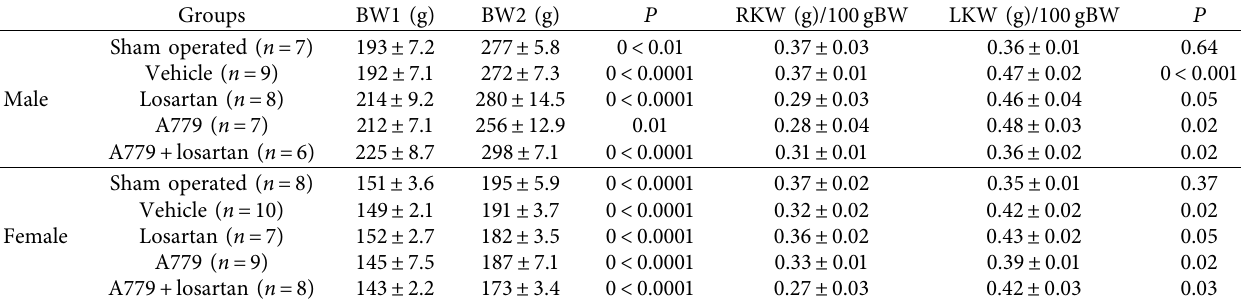
Figure 2: Systolic pressure (SYS, mmHg) in sham-operated and 2K1C groups. The data are reported as mean ± standard error of mean. ∗ Significant difference from sham-operated groups. The statistical P values were obtained using one-way ANOVA followed by the LSD post hoc test. Table 1: The male and female data for body weight before clipping operation (BW1) and 28 days after 2K1C implementation (BW2).